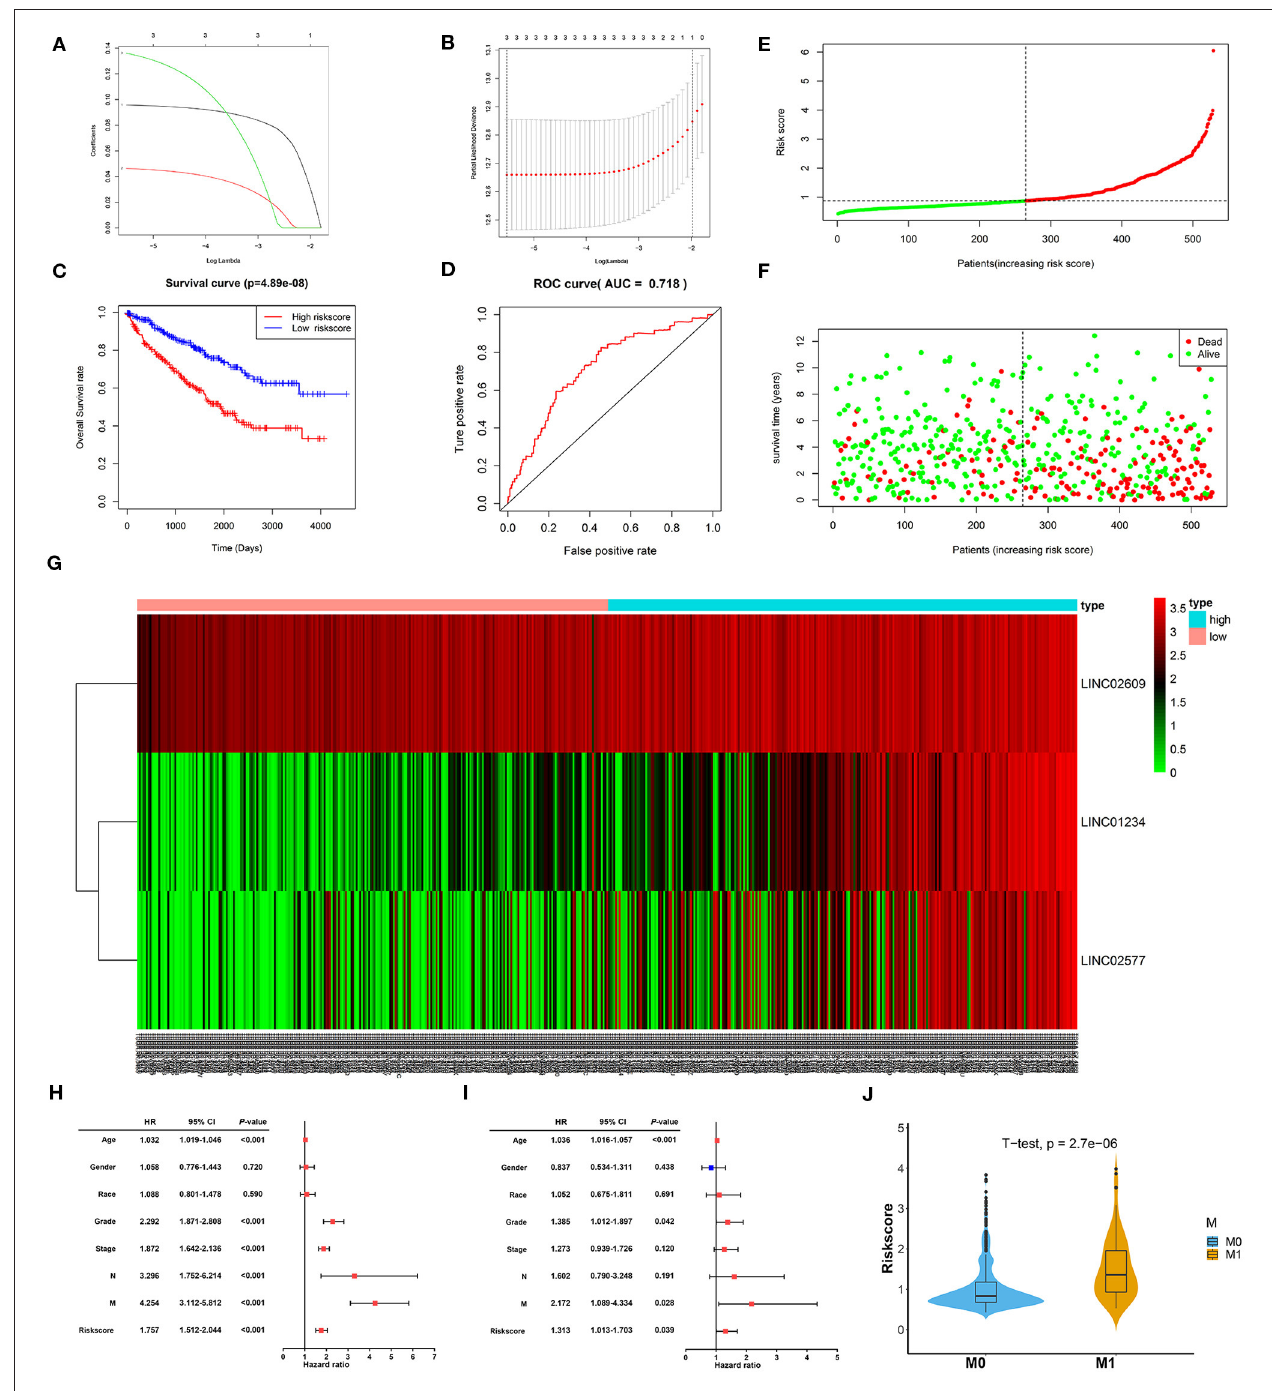
FIGURE 9 | Constructionand assessment of the 3-lncRNA prognostic signature. (A) The coefficients in the LASSO regression for key lncRNAs. (B) Cross-validation for tuning parameter selection in the LASSO regression. (C) Kaplan–Meier curve to compare the OS between high- and low-risk score groups. (D) ROC curves showing predictive value of the 3-lncRNA prognostic signature. (E) Distribution of the risk scores based on 3-lncRNA prognostic signature in patients with ccRCC. (F) Survival status and time of patients with ccRCC and different risk scores in the TCGA set. The patients with ccRCC were separated into high- and low-risk groups according to the median of risk score. Red dots mean non-survivors, and green dots mean survivors. (G) Heatmap and hierarchical clustering of the three lncRNAs in the prognostic signature. The right longitudinal axis means the name of key lncRNAs, and the left longitudinal axis means the clustering situation of key lncRNAs. Red and green, respectively indicate upregulation and downregulation of lncRNAs. The upper horizontal axis denotes patients with ccRCC, while the blue means patients with high-risk ccRCC and the pink means patients with low-risk ccRCC. (H) Univariate Cox regression analysis of correlations between the risk score for OS and